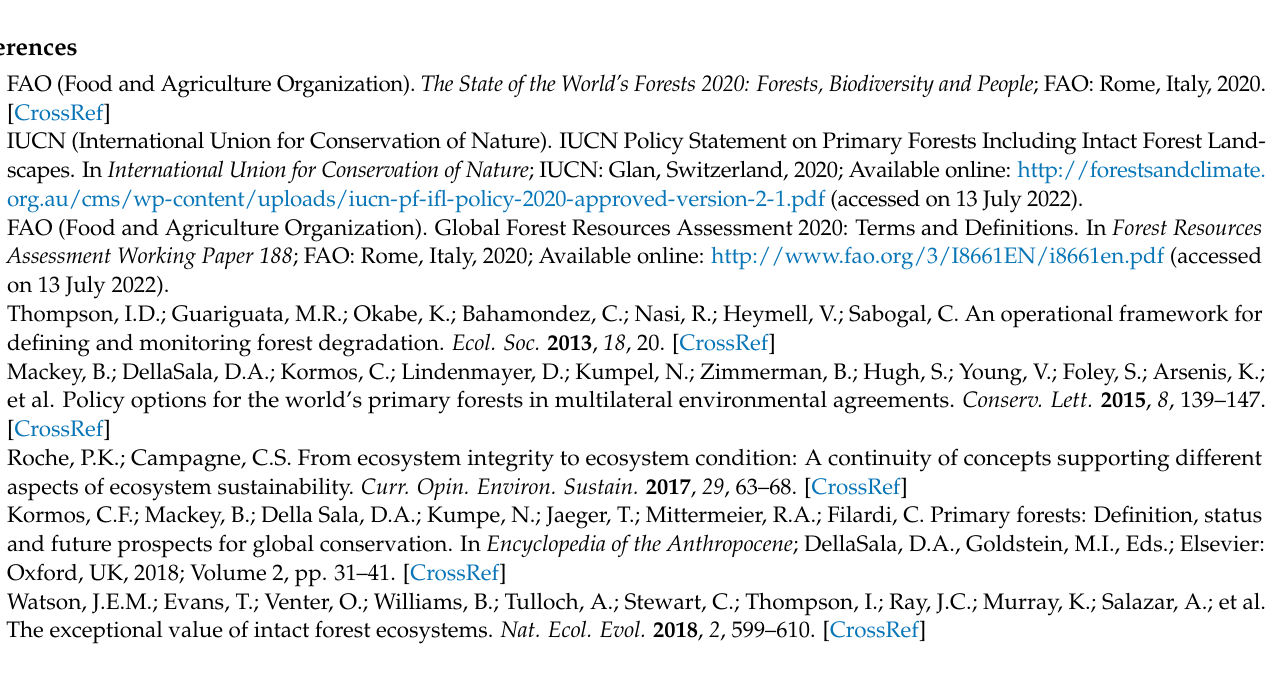
Figure S2: Representative time series of mean fPAR and SIWSI for southern taiga ecoregion (Siberia, Russia) and Kayap ó territory (Amazon basin, Brazil) over the period 2003–2018. Figure S3: Spatial constancy analysis for southern taiga ecoregion (Siberia, Russia) and Kayap ó territory (Amazon basin, Brazil). Figure S4: Spatial distribution of forest cover changes for southern taiga ecoregion (Siberia, Russia) and Kayap ó territory (Amazon basin, Brazil). Figure S5: Spatial distribution of vegetation types from the Land Cover Type product corresponding to the year 2018 for southern taiga ecoregion (Siberia, Russia) and Kayap ó territory (Amazon basin, Brazil). Table S1: Major climate characteristics of southern taiga ecoregion (Siberia, Russia) and Kayap ó territory (Amazon basin,